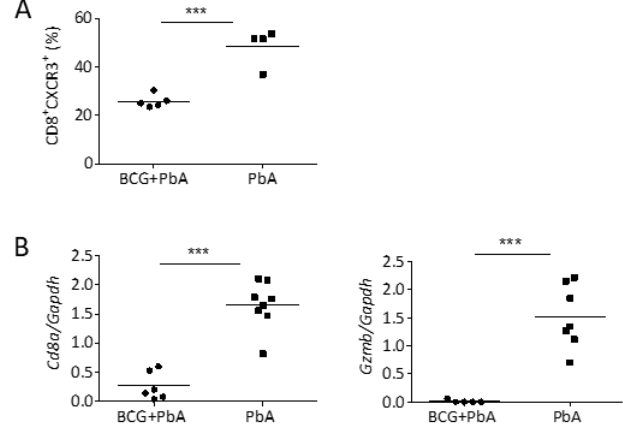
Figure 4. Assessment of CD8 + T cell responses in brain. ( A ) Flow cytometric assessment of CXCR3 + CD8 + T cells in the brain on day 8 post PbA infection in previously naive or BCG-vaccinated mice (n = 4–5). ( B ) Brains of mice that were or were not immunized with BCG 30 days before PbA SPZ challenge were analyzed for the expression of Cd8a and Gzmb by qRT-PCR (n = 6–8). Data from one of two independent experiments are shown. Symbols and bars represent individual mice and means, respectively. *** p ≤ 0.001 determined by Student´s t -test.